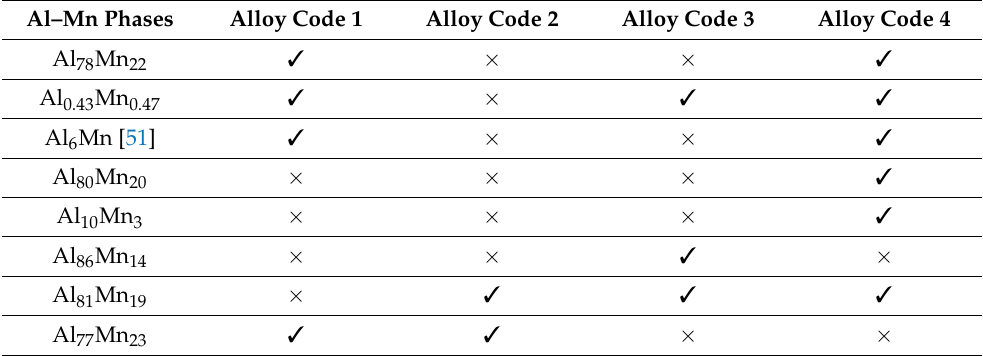
Table 9. Combinations of Al–Mn phases present in alloy codes 1 to 4 based on XRD textures. ([ (cid:51) ] and [ × ] denote the presence and absence of the respective phase, respectively).